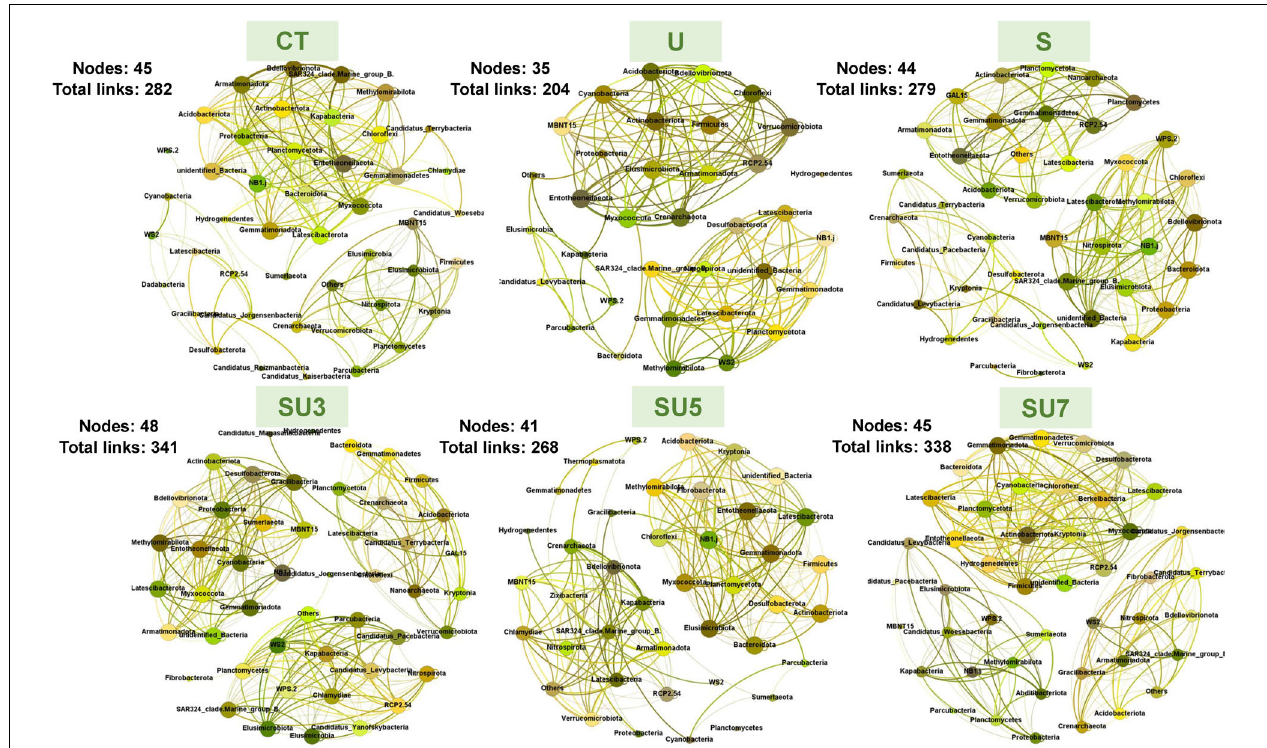
FIGURE 5 | Overview of bacterial networks in the rhizosphere soil at the maize silking stage under different N fertilizer treatments (including CT, U, S, SU3, SU5, and SU7), with node size proportional to node connectivity. Node color represents various phylogenetic